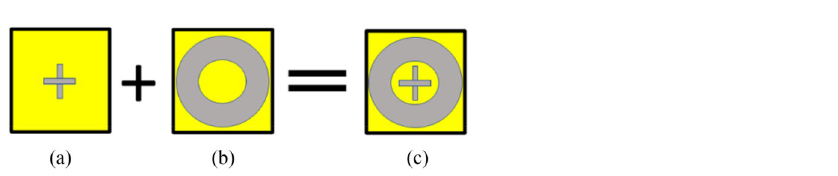
Figure 2. Generation of the proposed FSS geometry, ( a ) cross-dipoles, ( b ) outer ring, and ( c ) a combination of cross-dipoles and ring.